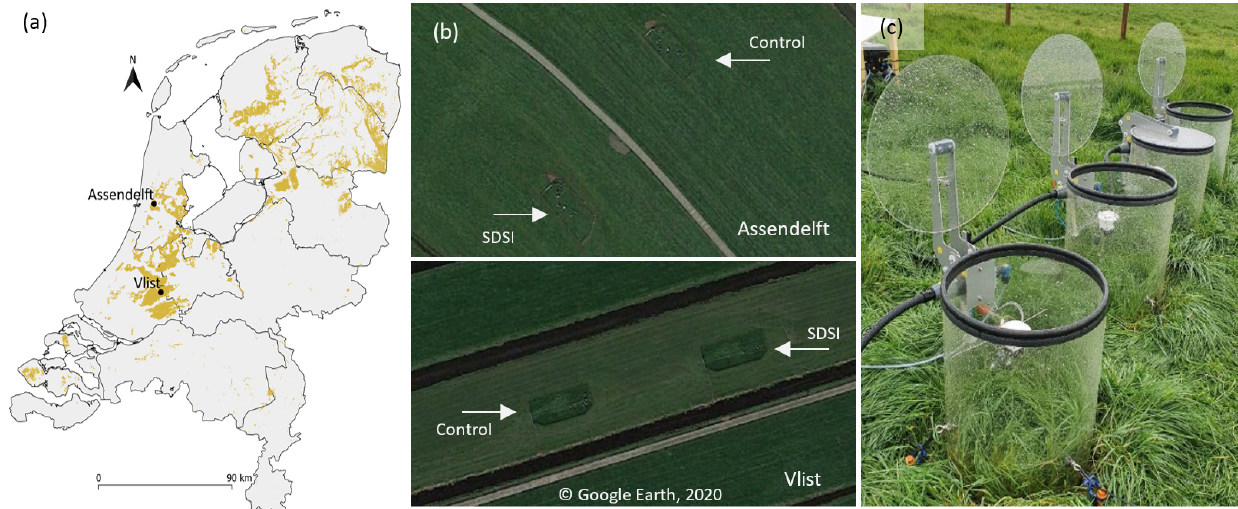
Figure 2. (a) Peat soils in the Netherlands (highlighted) with the research locations Assendelft and Vlist on a national scale (Basisregistratie Ondergrond, 2018; Esri Nederland, 2021), (b) the research locations seen from 500m altitude with satellite imagery (the borders of the measuring plots are recognizable by the fences), and (c) the automated transparent chamber systems in